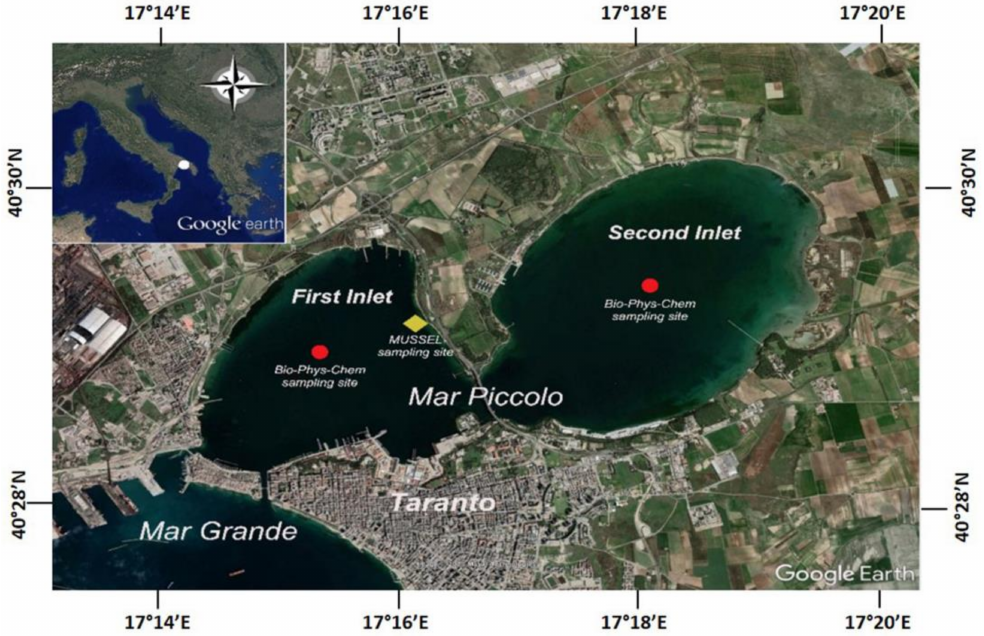
Figure 1. Map of sampling stations in the Mar Piccolo (Taranto, Northern Ionian